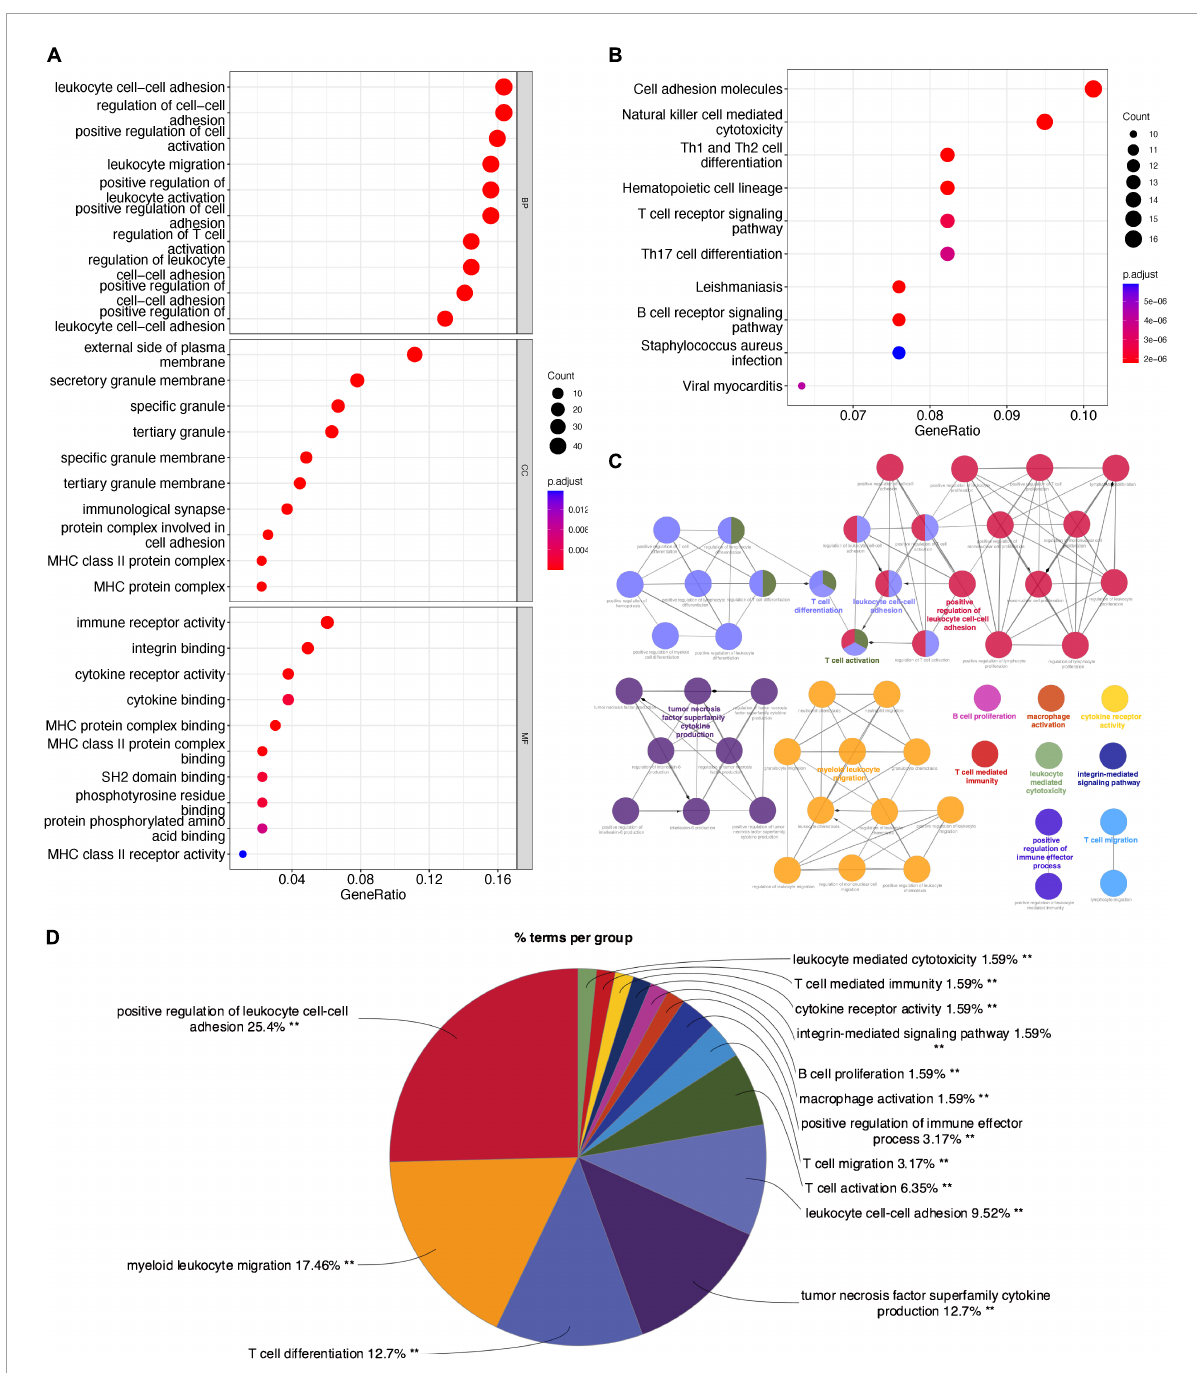
FIGURE5 Enrichment analyses of feature genes in CAVD datasets. (A) GO enrichment analysis of the feature genes, at three levels: biological process, cellular component, and molecular function. (B) KEGG pathway analysis of the feature genes. (C) The interaction network of GO terms, the significant term of each group was highlighted. (D) The proportion of each GO terms group in the total, ** P <